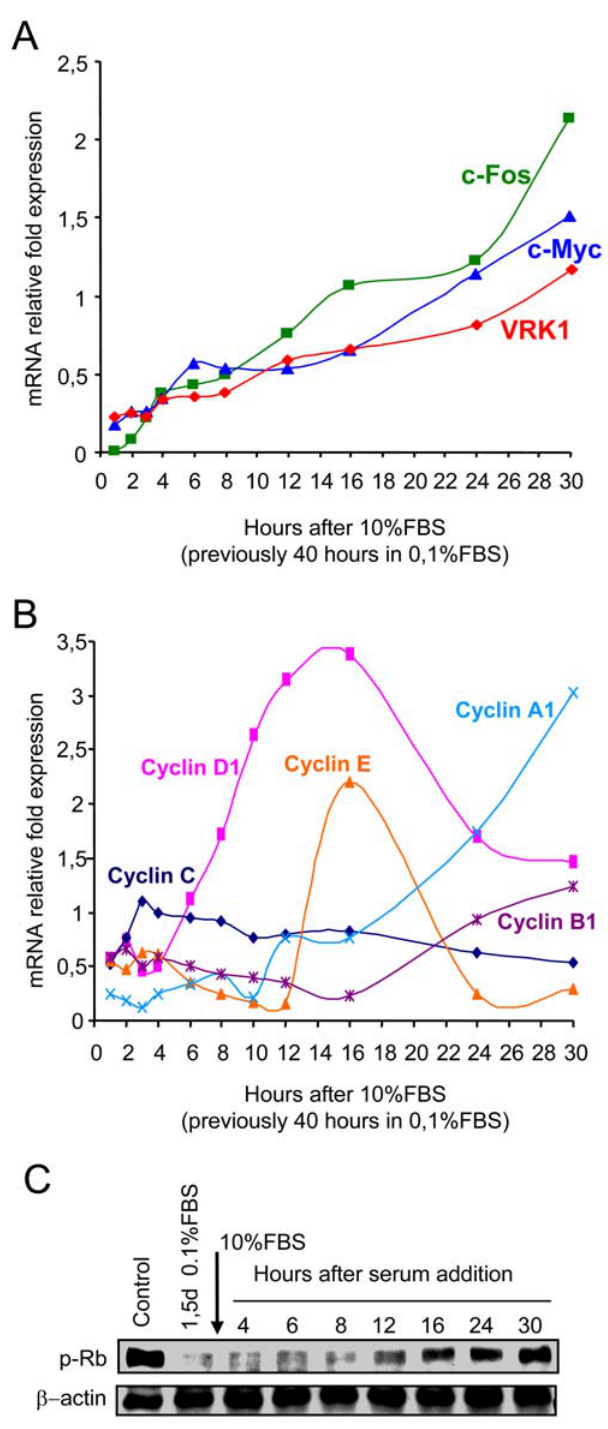
serum readdition. (A). Expression of MYC , FOS and VRK1 genes after serum readdition to the culture. Before serum readdition cells were maintained for forty hours in 0.1% FBS. (B). Sequential expression of five cyclin genes after serum readdition to starved WS1 cells. (C ) . Timing of Rb phosphorylation after serum readdition to the starved WS1 cell culture detected with a specific anti p-Rb antibody. These experiments were independently performed three times.